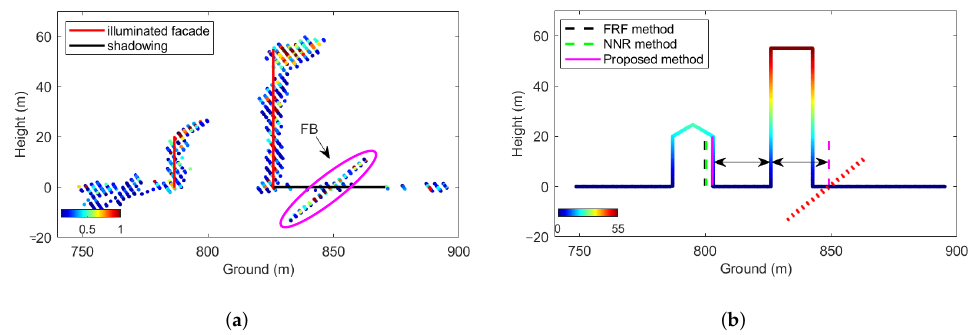
Figure 11. Results of the simulated scene 2. ( a ) TomoSAR point cloud. The colormap indicates the normalized scattering intensity. ( b ) The reconstruction results of the back of building 1, where the line colored by height indicates the true value.